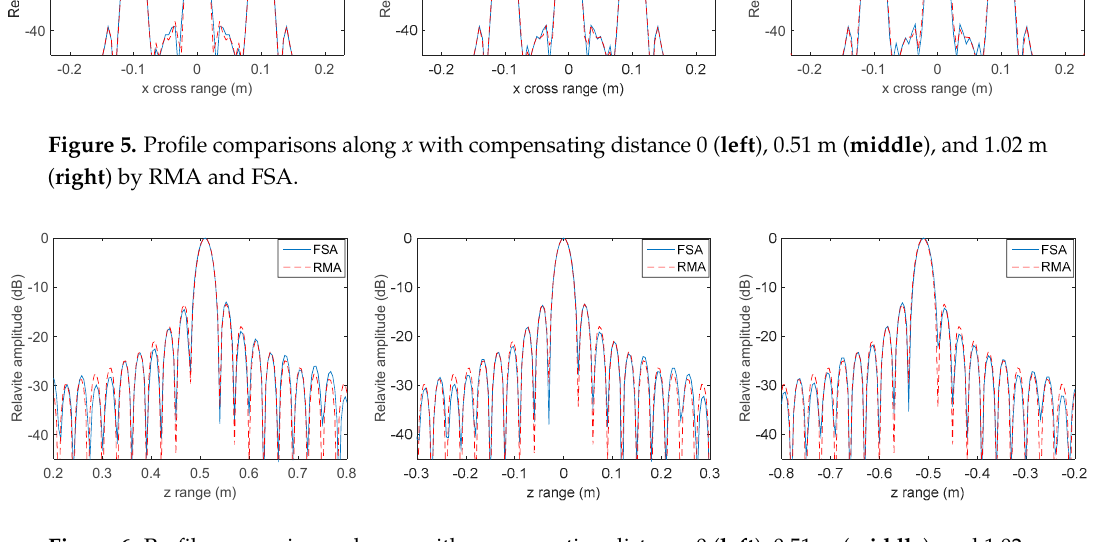
Figure 6. Profile comparisons along z with compensating distance 0 ( left ), 0.51 m ( middle ), and 1.02 m ( right ) by RMA and